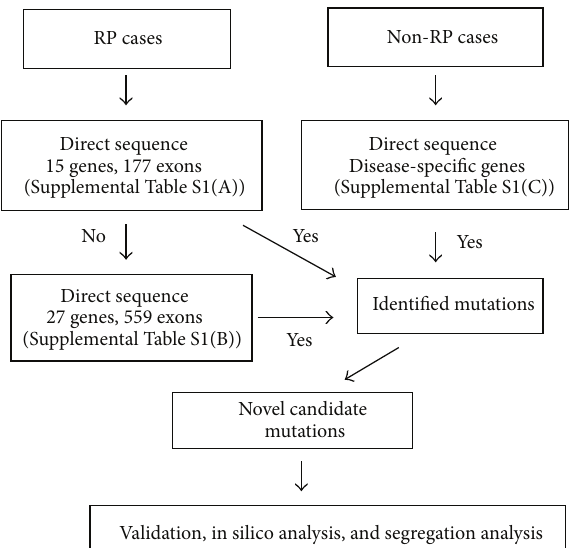
Figure 1: A stepwise screening for patients with IRD. Molecular diagnosis was performed with a stepwise screening methodology.